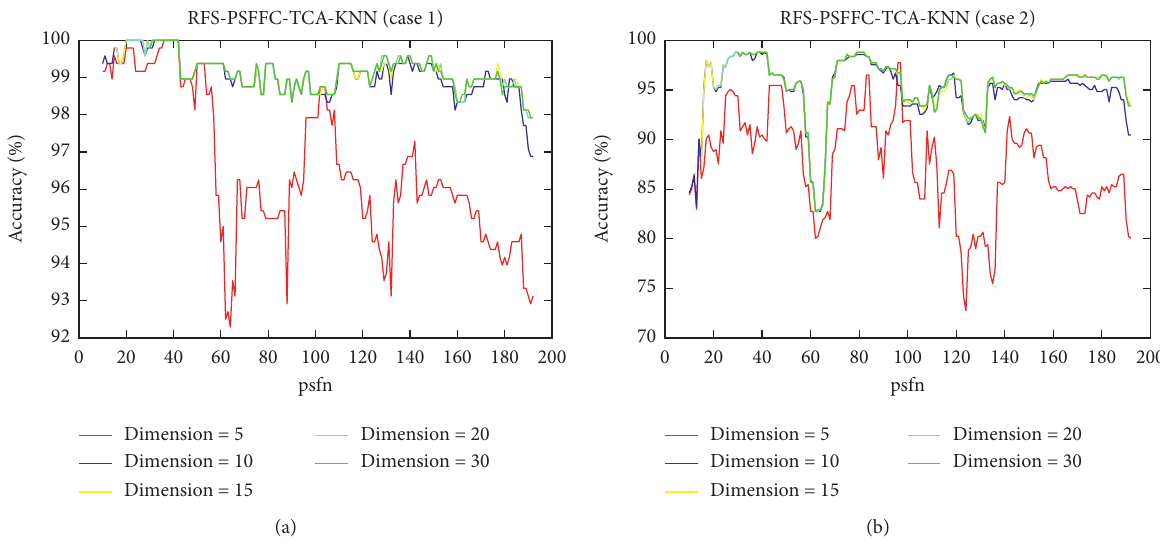
Figure 19: The testing accuracies of RFS-PSFFC-TCA-KNN with different dimension sizes for